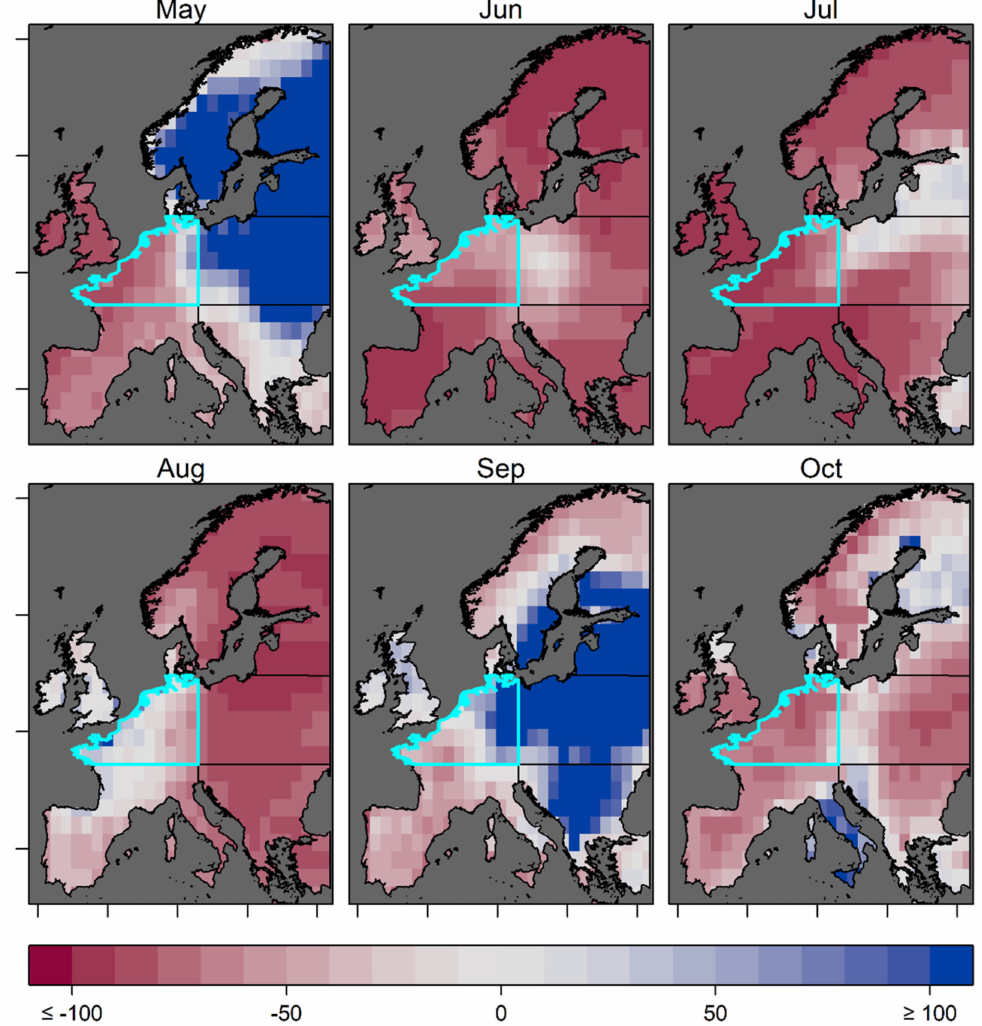
Figure 8. The 2018 monthly difference in land evaporation originating from source regions and falling in sink region 3 (cyan outlined) (Equation (5)), expressed as